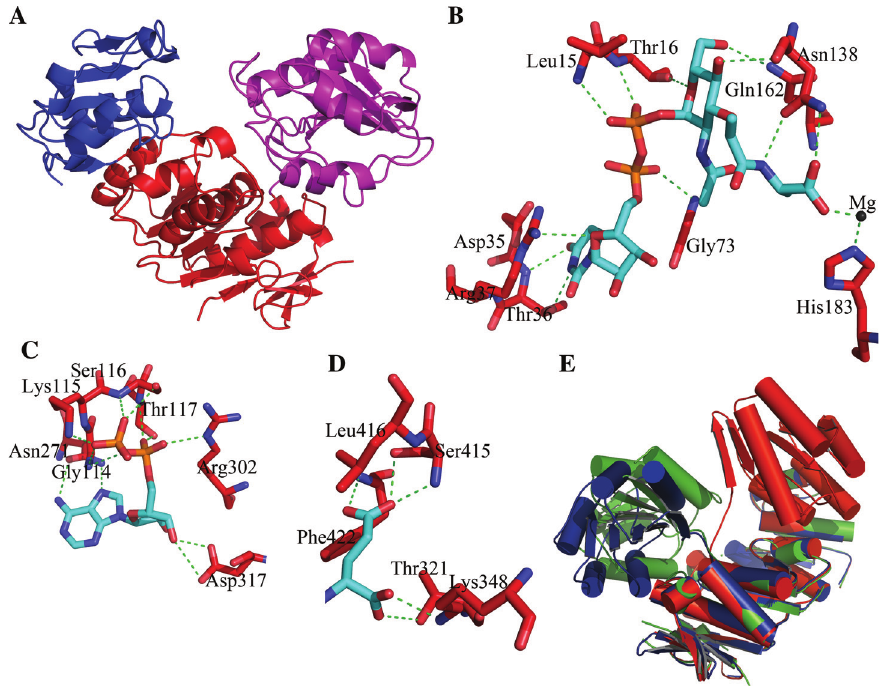
Figure 1 Tridimensional structure of, and interactions of ligands with, E. coli MurD. (A) Tridimensional structure of E. coli MurD (PDB entry: 4UAG). Blue: N-terminal domain; red: central domain; magenta: C-terminal domain. (B) Interactions of UDP-MurNAc-l-Ala with MurD. (C) Interactions of ADP with MurD. (D) Interactions of d-glutamic acid with MurD. (E) Super- position of closed conformation (green, PDB entry: 2UAG) with two open conformations (blue, PDB entry: 1E0D; red, PDB entry: 1EEH) of E. coli MurD. N-terminal and central domains were